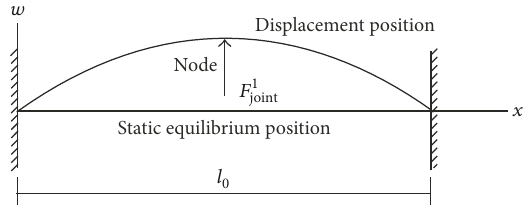
Figure 3: Modeling of the tri-cross string by separating the three strings of the structure and adding a joint force to the joint as the joint